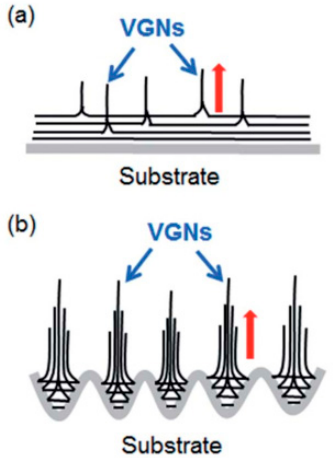
Figure 16. Scheme for the mechanism of VGN growth on ( a ) untreated and ( b ) Ar plasma-treated substrates (reprinted with permission from [132]).